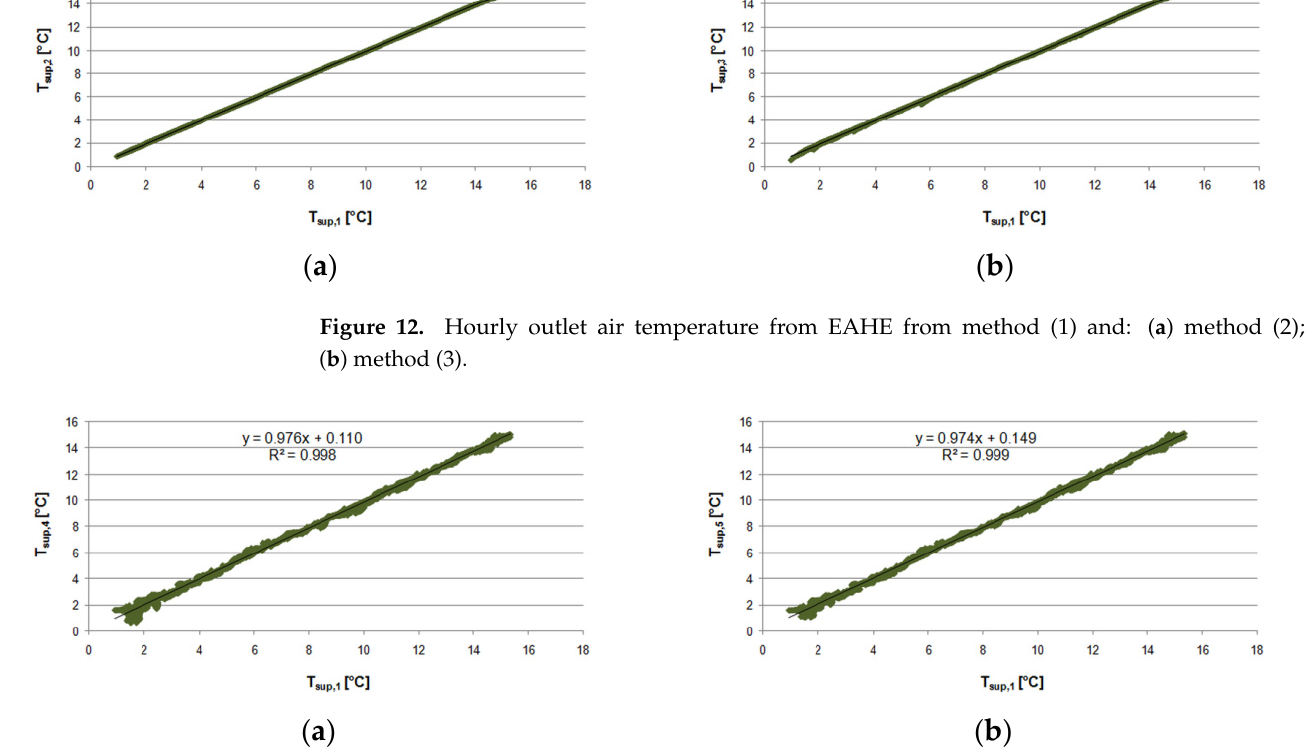
Figure 13. Hourly outlet air temperature from EAHE from method (1) and: ( a ) method (4); ( b ) method (5).